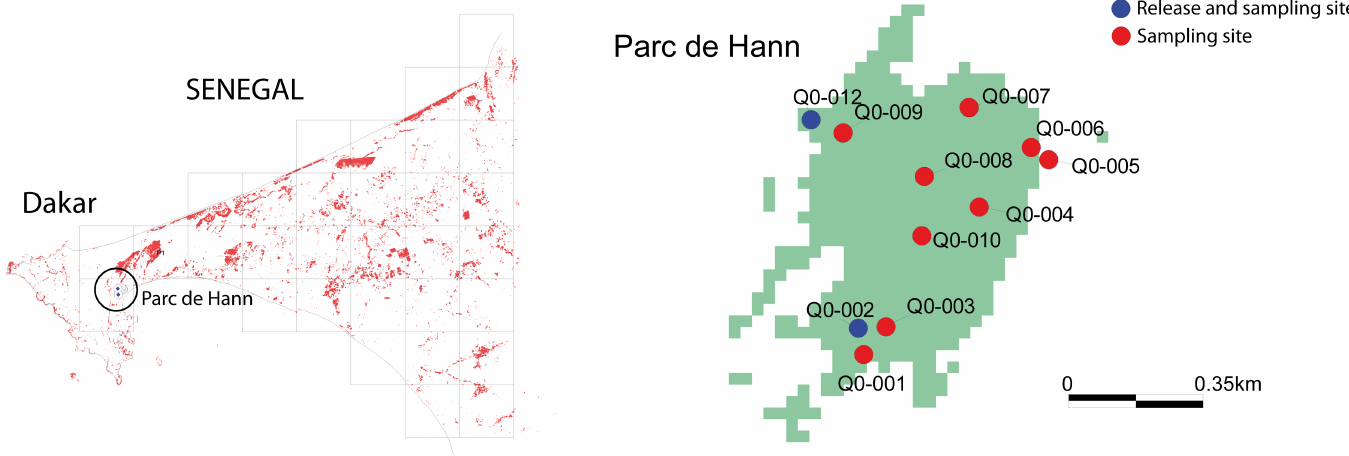
Fig 1. Study area indicating the releaseand sampling sites. On the left panel, grid cells represent 5 * 5 km squaresin the Cap Vert peninsula around Dakar, Senegal.The Parc de Hann is indicatedby the black circle.